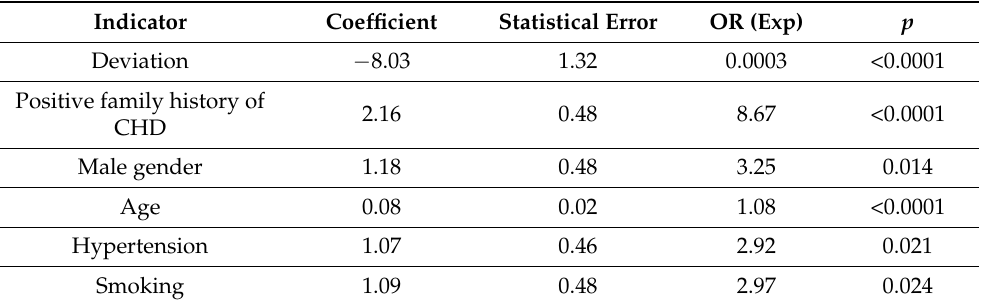
Table 9. Statistical significance of coefficients in calculating the odds ratio of the combined end point (CEP) in patients with